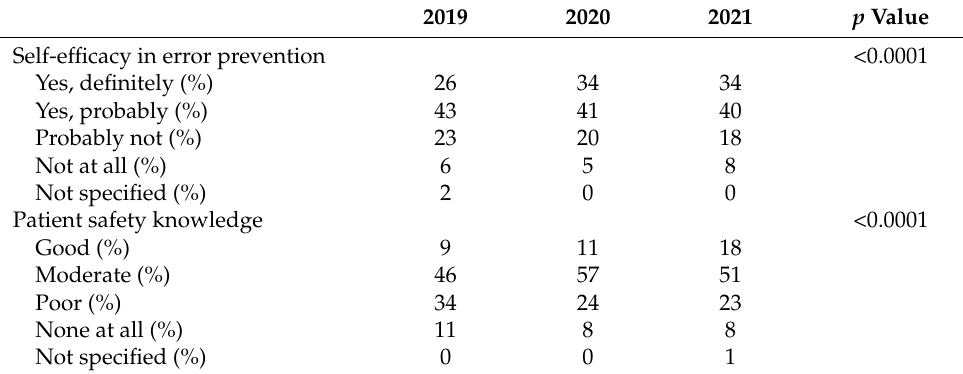
Table 3. Participants’ perceptions relating to self-efficacy in error prevention and knowledge about patient safety, 2019 to 2021 ( n = 1000 per year).